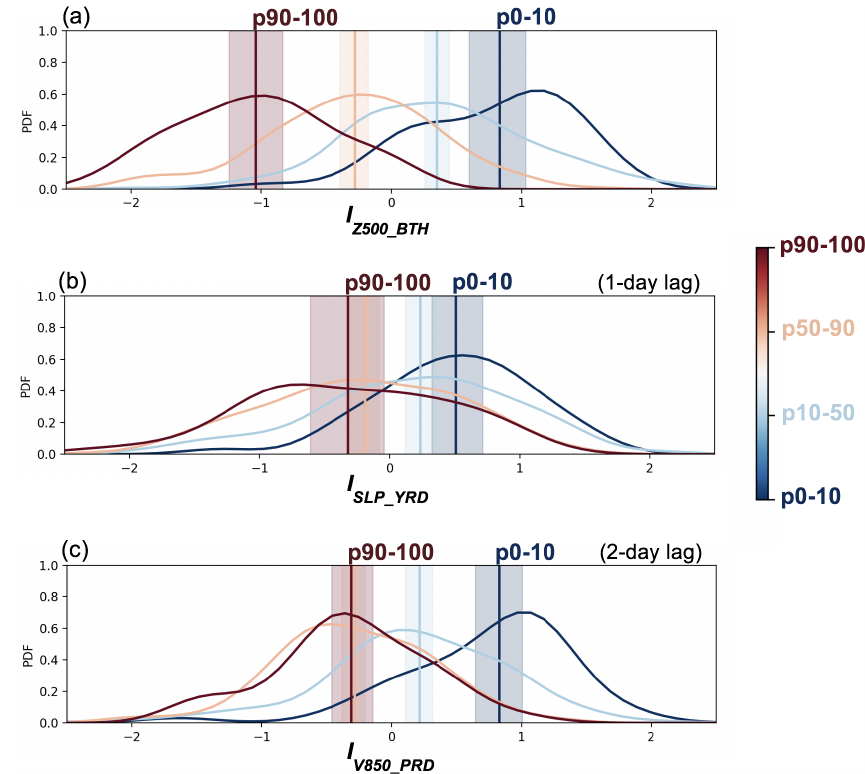
Figure 10. Frequency distributions of circulation-based indices for different percentile thresholds of daily mean PM 2 . 5 concentrations over (a) BTH, (b) YRD and (c) PRD during DJF 2013–2017. PM 2 . 5 concentration data are lagged by 1 and 2d with respect to the circulation indices for YRD and PRD, respectively. The vertical lines and shading represent the averages and the associated 95% confidence intervals, ( Q 1 + 2 Q 2 + Q 3), where Q1 is the lower quartile, respectively. Averages are calculated using Tukey’s trimean (e.g. Ge et al., 2019): X = 1 4 Q2 is the median, and Q3 is the upper quartile. The confidence intervals for these averages are estimated by using bootstrap resampling (e.g. Wang, 2001). This method generates samples by randomly choosing daily values of circulation-based indices (resampling with replacement) and then calculating Tukey’s trimean. This process is repeated 10000 times to get robust replicates of the mean. Ultimately, the lower and upper limits of the 95% confidence intervals are calculated as the values corresponding to the 2.5th and 97.5th